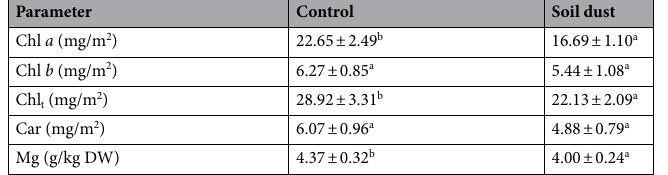
Table 5. Contents of chlorophyll, carotenoids and magnesium in the control and soil dust treatments. Chl a : chlorophyll a , Chl b : chlorophyll b, Chl t : total chlorophyll, Car: carotenoids. Values are means ± SD. Lower-case letters indicate significant differences based on Fisher’s LSD test ( p ≤ 0.05). Data with the same letter are not significantly different.